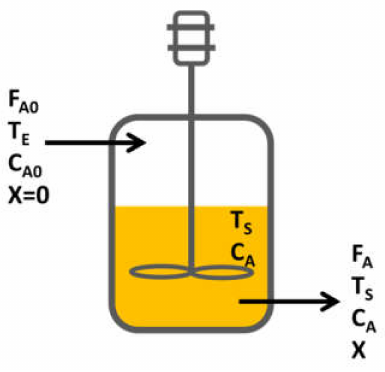
Figure 7. Scheme of a continuous reactor.